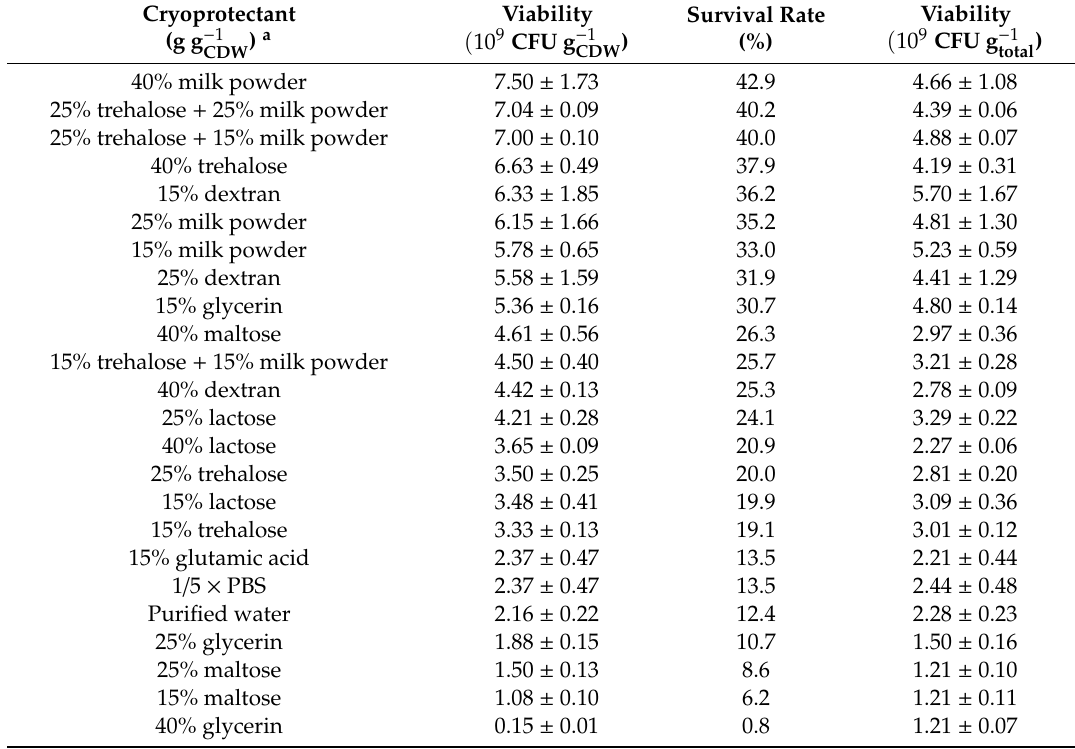
Table 1. Colony forming units and survival rates for freeze-drying S. cerevisiae with di ff erent cryoprotectant solutions. Rows are sorted in order of decreasing survival